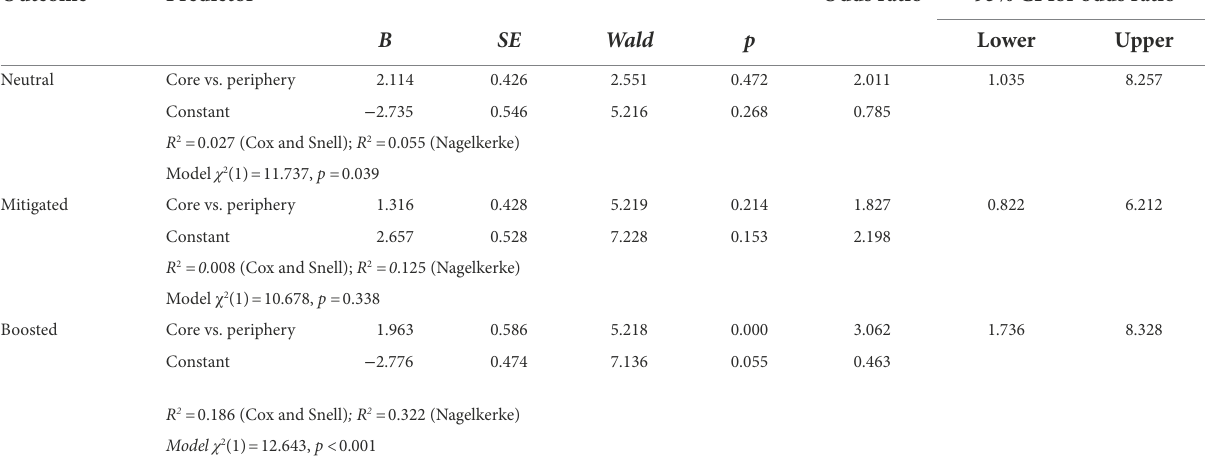
TABLE 6 Results of binary logistic regressions on the frame element of degree. Outcome